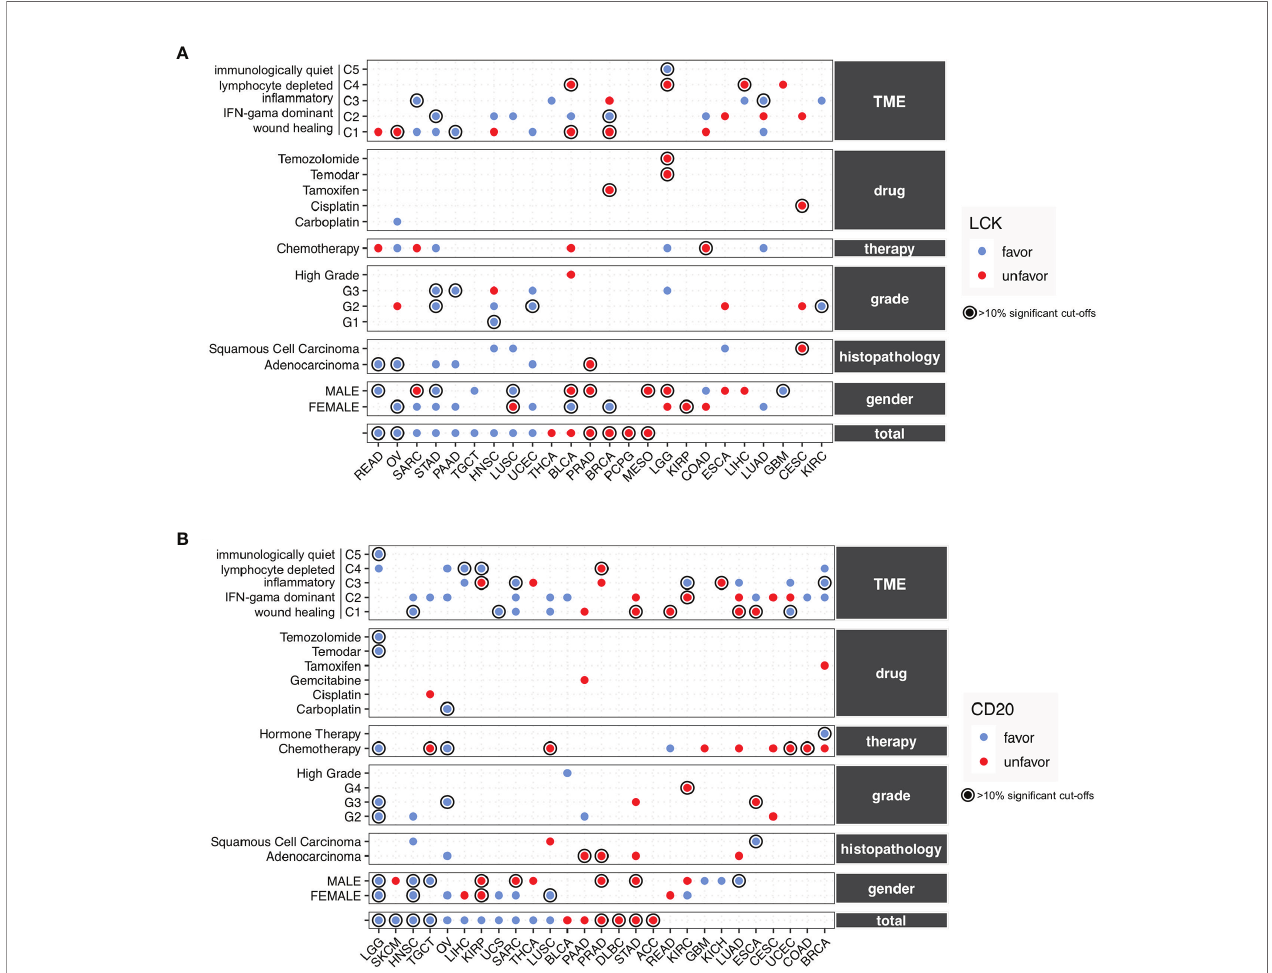
FIGURE 6 | The prognostic landscape of CD20 and LCK in different cancer types and subgroups de fi ned by gender, histopathology, histopathological grade, therapeutic approach, drug, and TME. (A, B) Prognostic signi fi cances of CD20 (A) and LCK (B) in the total cancer types and different subgroups, with favorable and unfavorable associations indicated by blue and red dots. The prognostic signi fi cances were shown using the average percentage of the signi fi cant cut-offs from OS, PFI, DFI, and DSS if available. The robust associations with percentages of more than 10% were underlined with circles. The detailed results of subgroup analyses could be found in Figures S12 – 17